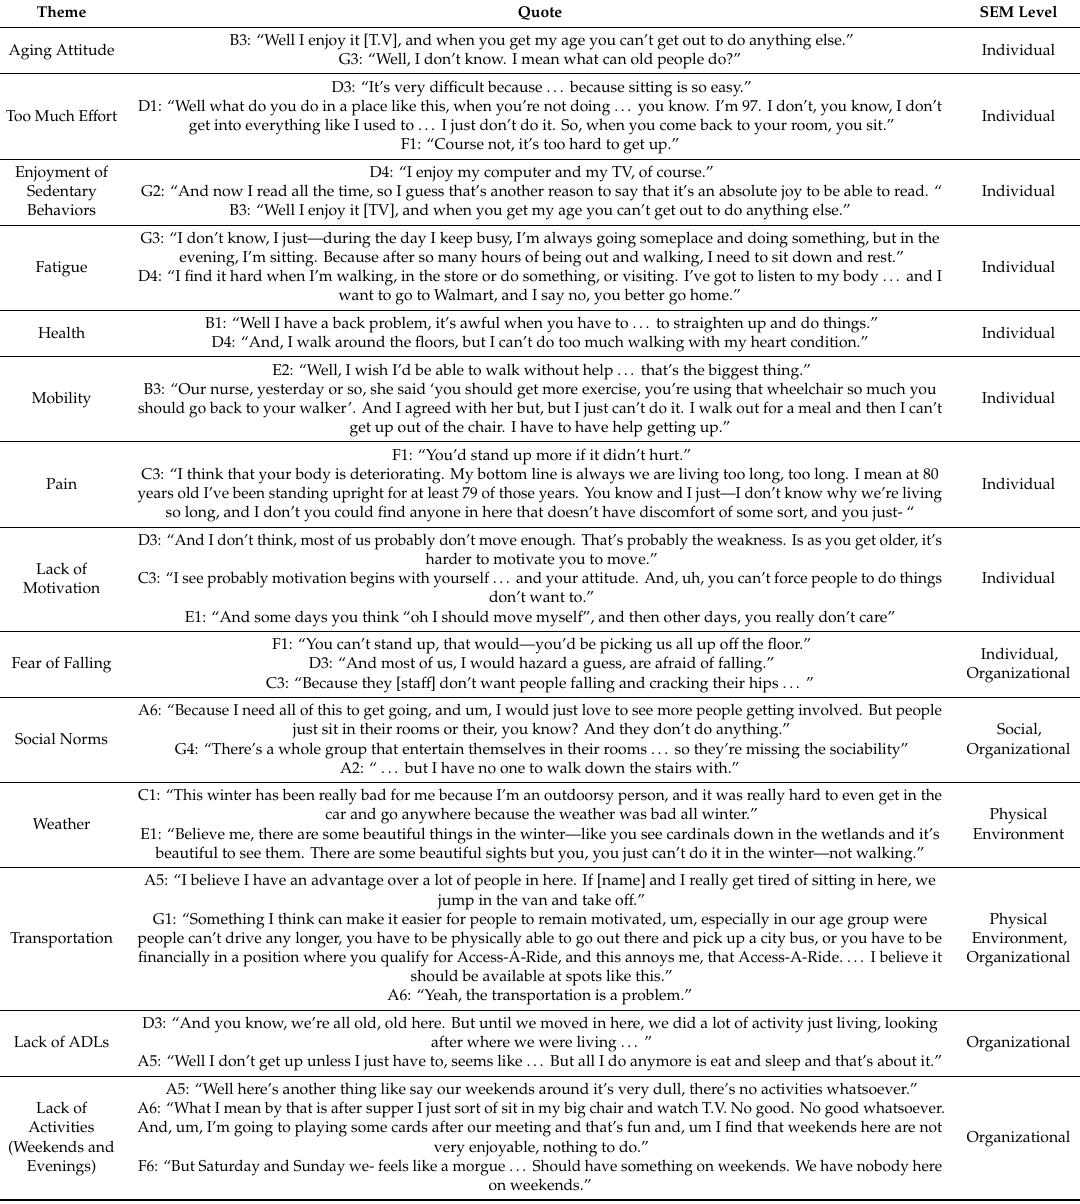
Table 2. Themes related to barriers to reducing sedentary time among older adults in assisted living, and associated level(s) of the Social Ecological Model